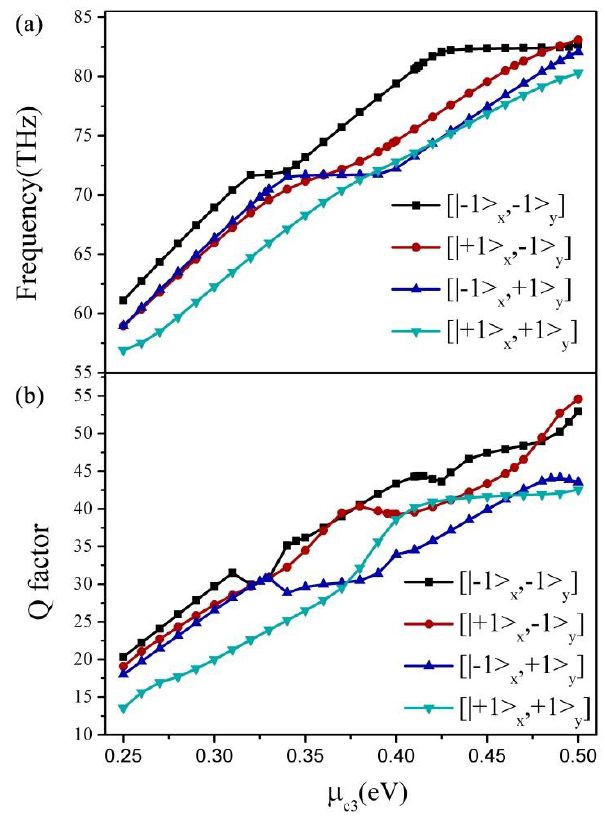
Figure 6. The variation of the frequency and Q factor of the fundamental mode as a function of the chemical potential µ c3 . ( a ) Resonance frequency; ( b ) Q